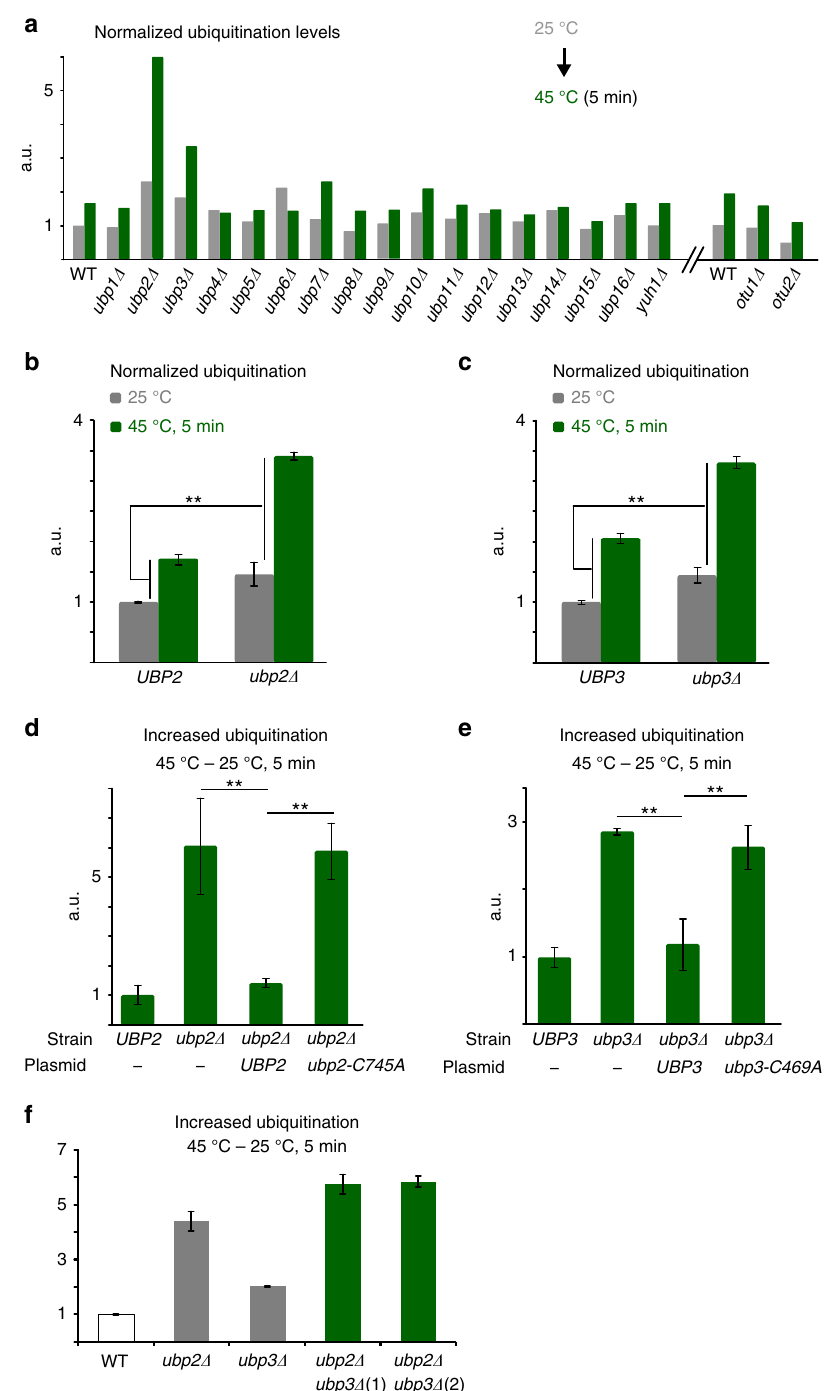
Figure 1 | Ubp2 and 3 control ubiquitination levels upon HS. ( a ) Ubiquitination levels were quantified by dot-blots and normalized to Pgk1 levels in WTand the indicated single-deletion strains. Cells were maintained at 25 (cid:2) C or incubated at 45 (cid:2) C for 5min. ( b , c ) Normalized ubiquitination levels were quantified by dot-blots (shown in Supplementary Fig. 1A) as in A and compared with a two-tail student t -test (** P o 0.01). ( d , e ) Differences of normalized ubiquitination levels between unstressed cells (25 (cid:2) C) and HS cells (45 (cid:2) C for 5min) quantified by dot-blots in the designated strains with the indicated plasmids (‘-’ denotes control empty plasmid). Increased ubiquitination levels were compared using a two-tail student t -test (** P o 0.01). ( f ) Differences of normalized ubiquitination levels before and after HS (45 (cid:2) C for 5min) quantified by dot-blots in the indicated cells. All experiments in b – f were done with three biological replicates and averaged values are shown with s.d. Results are shown as arbitrary units (a.u.) and each value is relative to the reference